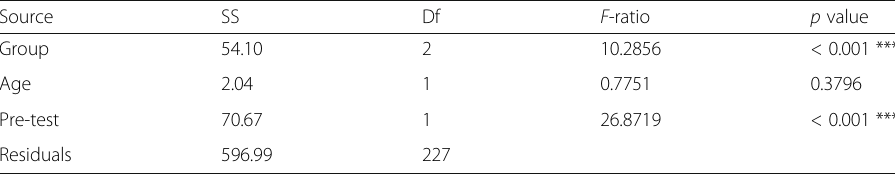
Table 18 Analysis of variance (ANOVA) type II result for Immediate test and pre-test Source SS Df F -ratio p value Group 54.10 2 10.2856 Age 2.04